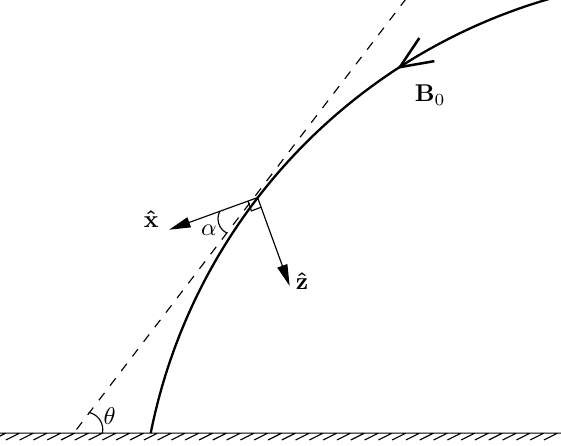
Fig. 7. Sketch of the ionospheric geometry showing the direction of propagation ˆ x at an angle α to the geomagnetic field B 0 in the xz-plane. θ , the dip angle, is the angle between ground and the geomagnetic field tangent at a certain height.